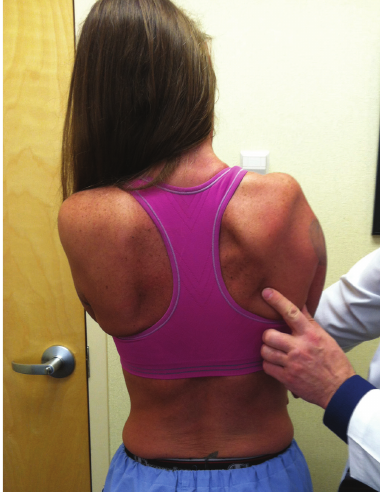
Figure 1: Photo taken at four months after the index TSA shows the patient’s right scapular winging with clear atrophy of the trapezius muscle. The patient is pressing her hands against the wall in front of